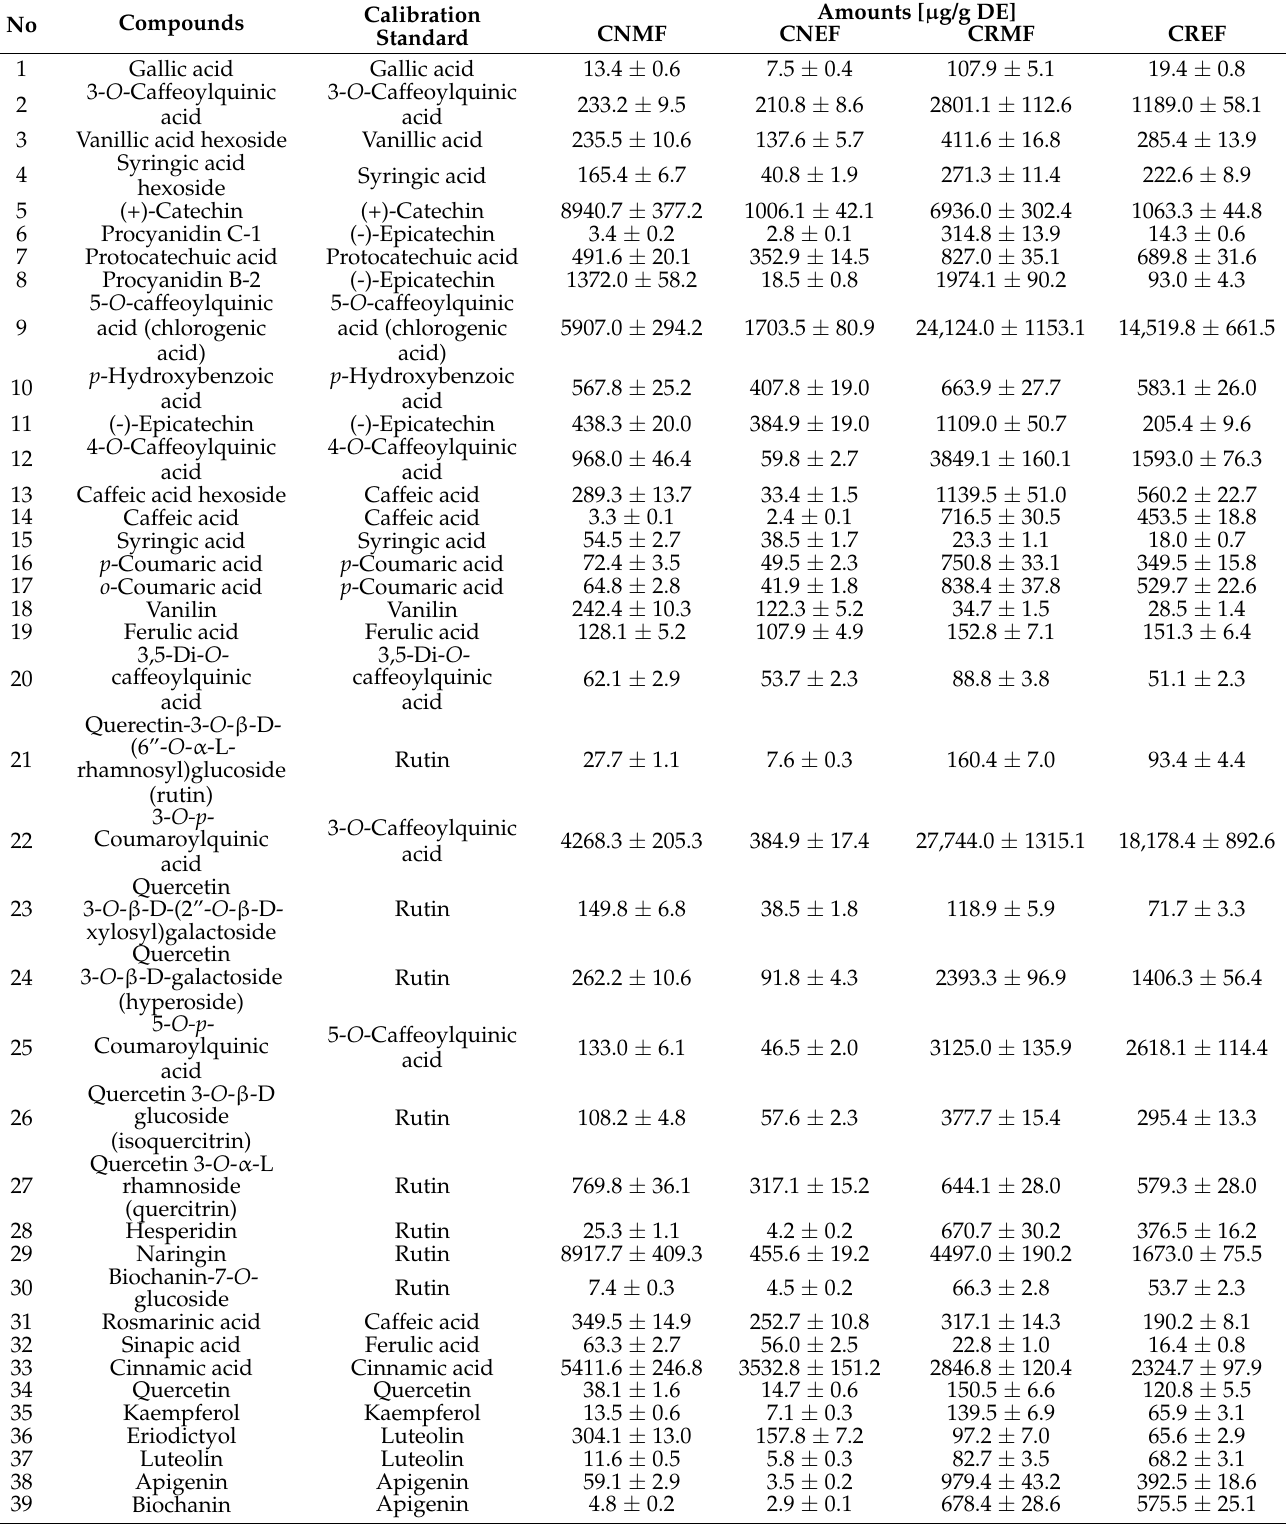
Table 3. Content of the active compounds (tentatively determined) in the fruits of C.